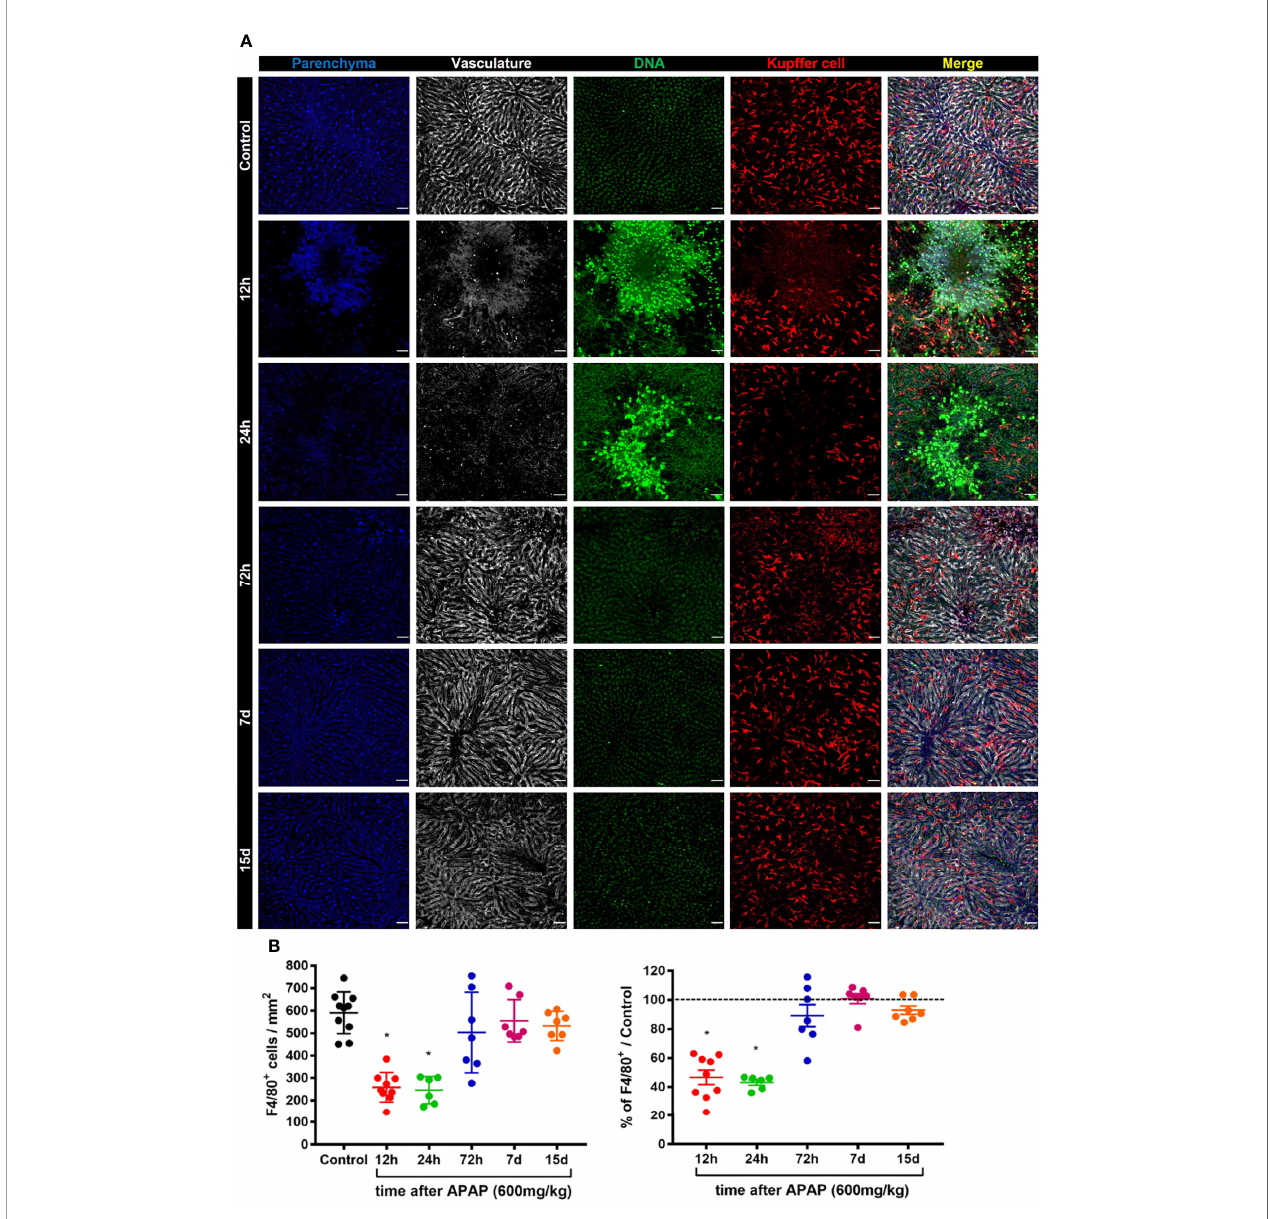
FIGURE 2 | ALI causes a dramatic reduction in the Kupffer cell population and disrupts an essential niche in the liver. (A) Representative intravital microscopy (IVM) images acquired during ALI to characterize liver architecture and Kupffer cell population; Parenchyma is represented by liver auto- fl uorescence (blue); Vasculature is stained by anti-CD31 PE antibody (white); Kupffer cell is stained by anti-F4/80 APC (red); DNA is stained Sytox green (green). Representative of 2 independent experiments; scale bar = 50 µm. (B) Kupffer cell quanti fi cation (Left panel) and the percentage based on Control (Right panel; —— = 100%); n ≥ 5 mice per group and 10 images per mice. Data are presented as mean ± SD. * indicates statistical difference compared to the control group using one-way ANOVA followed and Tukey post-test (* = p <